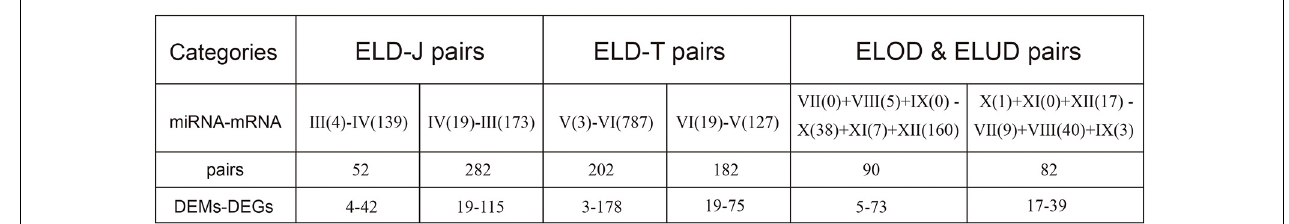
FIGURE 6 | Possible negative miRNA-mRNA interactions based on the 12 expression patterns.